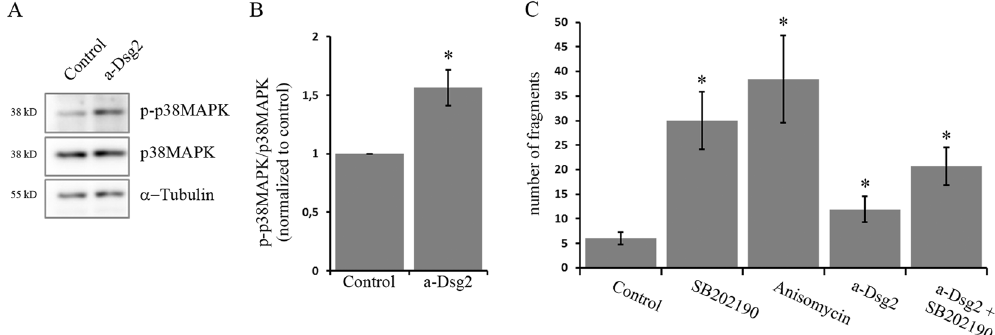
Figure 3. Inhibition of Dsg2 binding resulted in increased p38MAPK activity which is critical for enterocyte cohesion. ( A ) Western blot analysis after incubation of DLD1 cells with a Dsg2-specific antibody for 30 min revealed increased phosphorylation of p38MAPK. Cropped blots are displayed and full-length blots are included in the supplementary information. ( B ) Band intensity of detected p-p38MAPK was quantified using ImageJ and normalized to control (shown is mean ± SE, n = 6, * p < 0,05 compared to control). ( C ) DLD1 cells were treated with the p38MAPK inhibitor SB202190 or the activator anisomycin and analysed in a dispase- based cell dissociation assay. Both resulted in increased cell monolayer fragmentation. (Shown is mean ± SE, n = 3, * p < 0,05 compared to